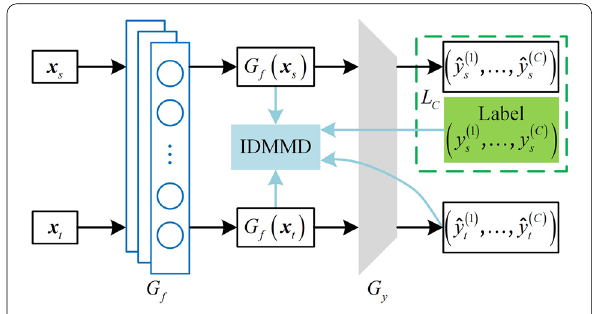
Figure 1 Framework of